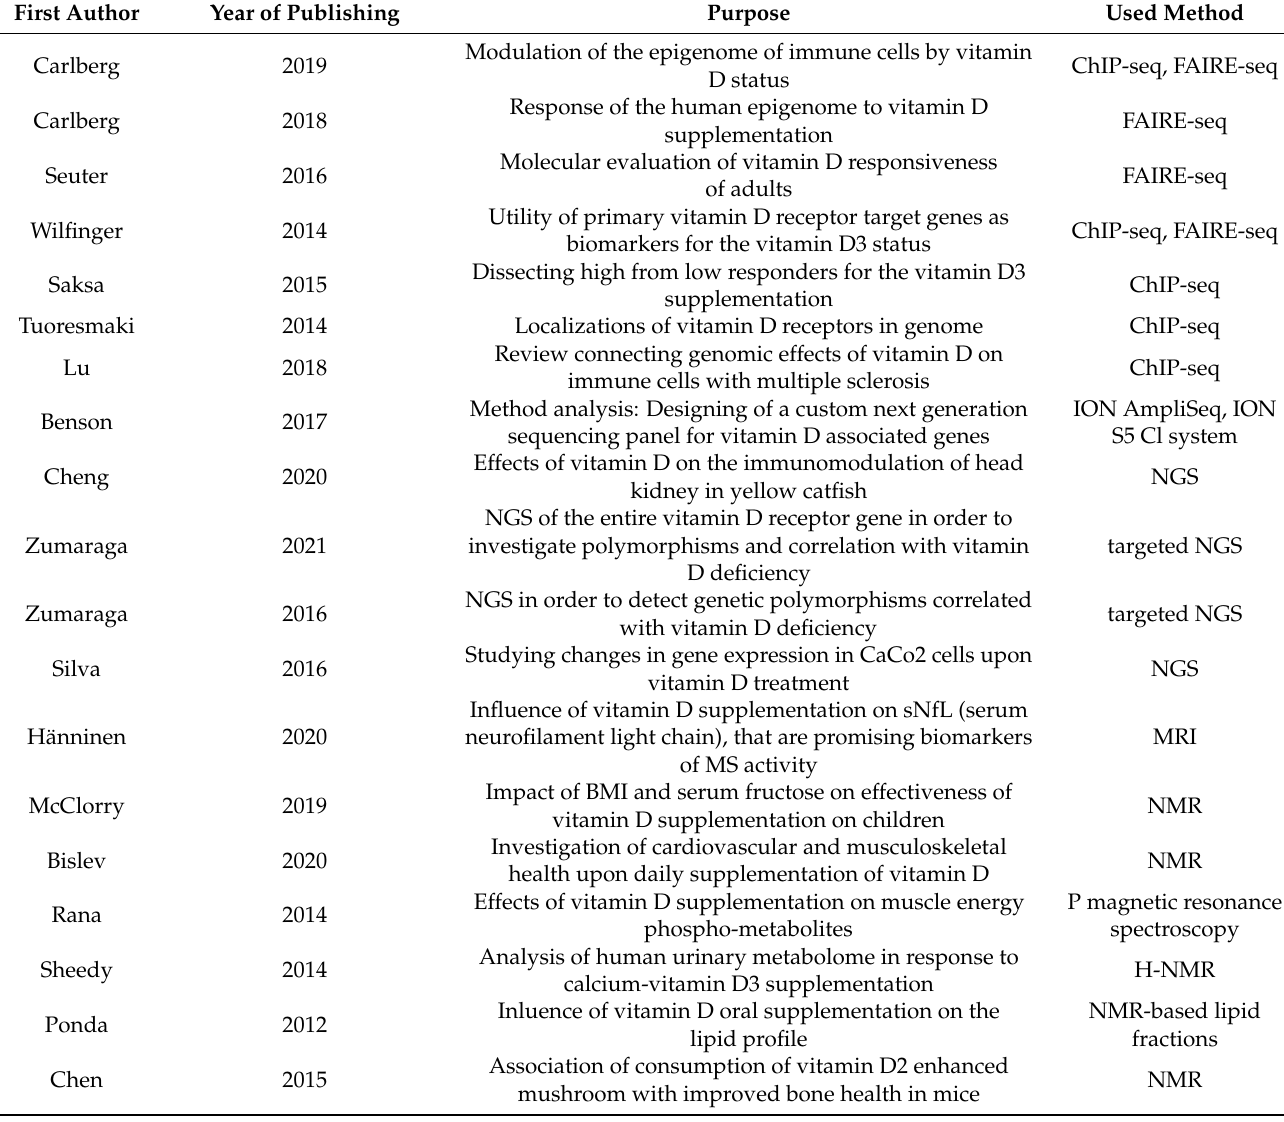
Table 1. List of publications describing the use of omics techniques in the study of vitamin